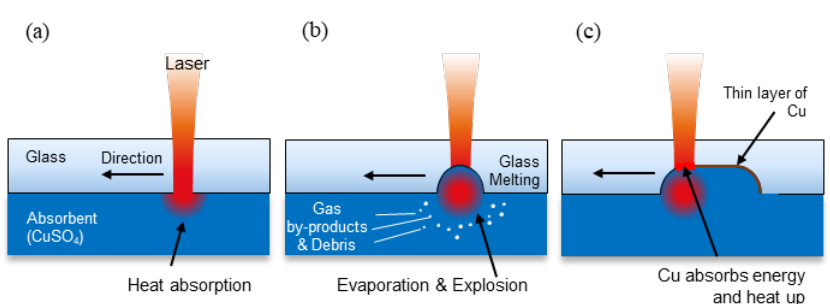
Figure 1. Brief mechanism of the LIBWE process: ( a ) An irradiated laser beam is absorbed by the absorbents. ( b ) Glass is removed by the heated absorbents. ( c ) Glass is continuously removed by the heated metal layer and absorbents.